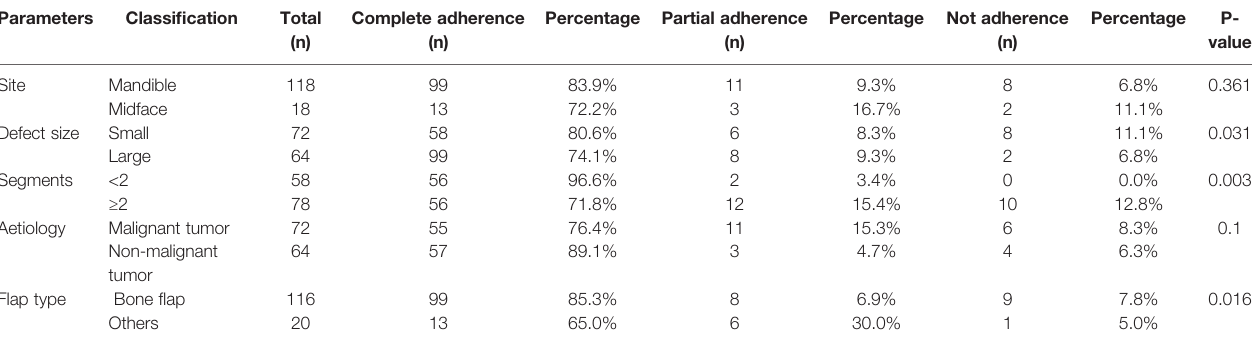
TABLE 3 | In fl uential parameters on the adherence of